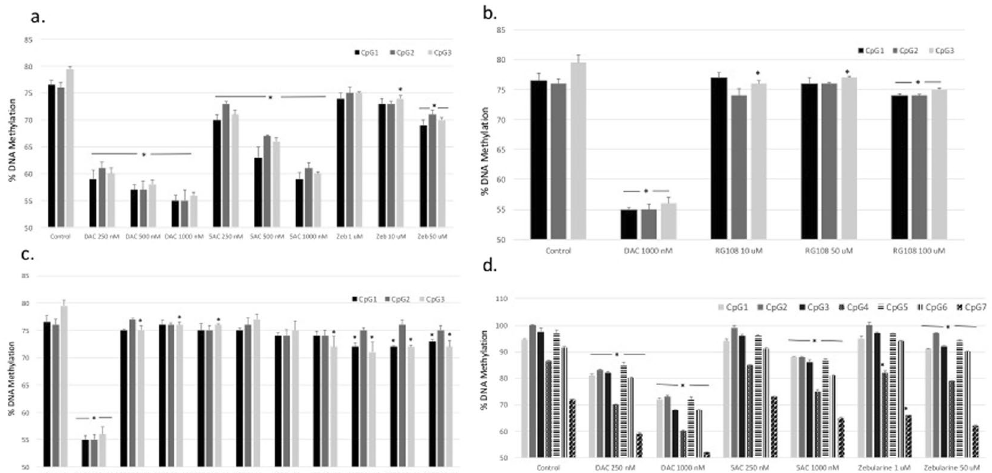
Figure 1. Comparing the DNA hypomethylating activity of DHAs. ( a ) CEM leukemia cells were treated with different concentrations of decitabine (DAC), 5-azacytidine (5AC) and zebularine (Zeb) for 48 h followed by DNA extraction, DNA bisulfite treatment and DNA pyrosequencing of three CpG sites in the LINE-1 sequence (GenBank accession number X58075) as described under methods. ( b ) CEM leukemia cells were treated with different concentrations of decitabine (DAC) or RG-108 for 48 h followed by DNA extraction, DNA bisulfite treatment and DNA pyrosequencing of three CpG sites in the LINE-1 sequence as described under methods. ( c ) CEM leukemia cells were treated with different concentrations of decitabine (DAC), EGCG, 6-thioguanine (6-TG) or PEITC for 48 h followed by DNA extraction, DNA bisulfite treatment and DNA pyrosequencing of three CpG sites in the LINE-1 sequence as described under methods.( d ) CEM leukemia cells were treated with different concentrations of decitabine (DAC), 5-azacytidine (5AC) and zebularine (Zeb) for 48 h followed by DNA extraction, DNA bisulfite treatment and DNA pyrosequencing of seven CpG sites in the CDKN2B (p15) sequence as described under methods. In all experiments, data represent the average of duplicates ± SD. * Indicates significant difference from the corresponding control CpG site at p < 0.05.